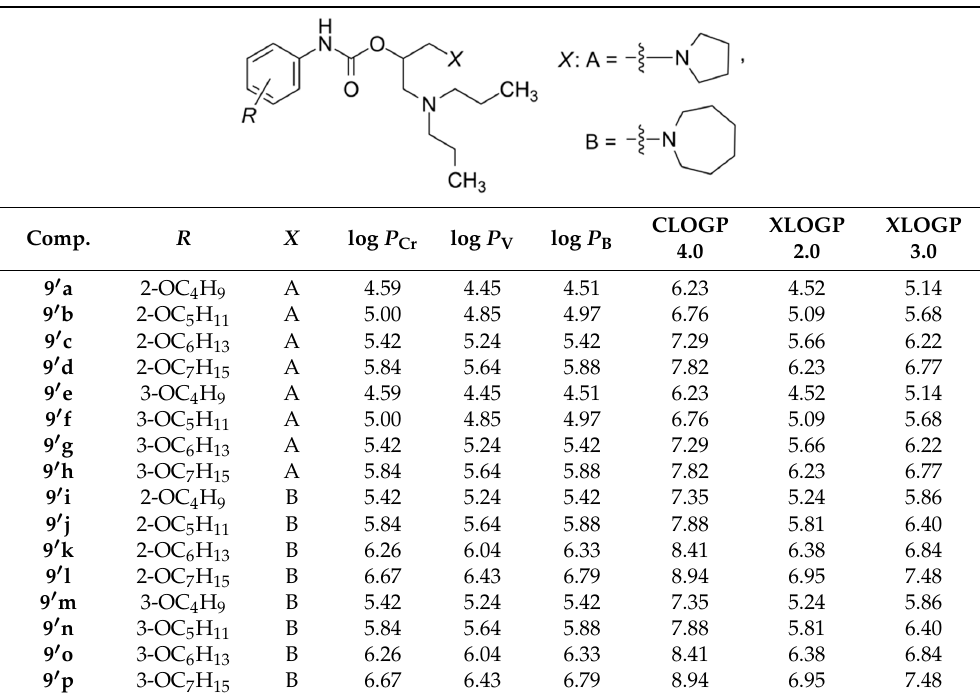
Molecules 2018 , 23 , x FOR PEER REVIEW 12 of 36 P S-IT and ALOGPs 2.1 (Tables 4 and 5), respectively, were statistically extremely significant ( Prob > F = 0.0001) and were defined by R > 0.9300, Adj. R 2 > 0.8650, F > 99.00 and other common statistical descriptors (Equations (S13)–(S24) in Table S6). Table 4. Values of logarithms of partition coefficients of basic (non-protonated) compounds 9 ′ a – p predicted for the octan-1-ol/water partitioning system by the Ghose and Crippen ′ s approach (log P Cr ), Viswanadhan ′ s principle (log P V ), Broto ′ s algorithm (log P B ) and CLOGP method (CLOGP 4.0), respectively, as well as by both XLOGP approaches (XLOGP 2.0 and XLOGP 3.0).